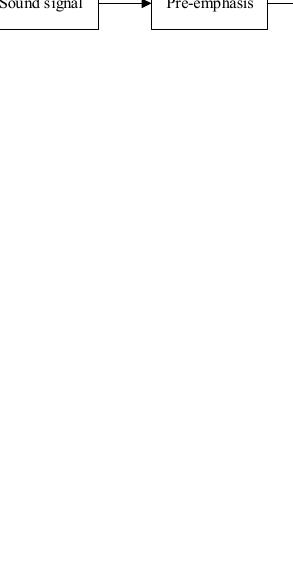
Table 3. Ten prediction accuracies achieved on the five data sets.